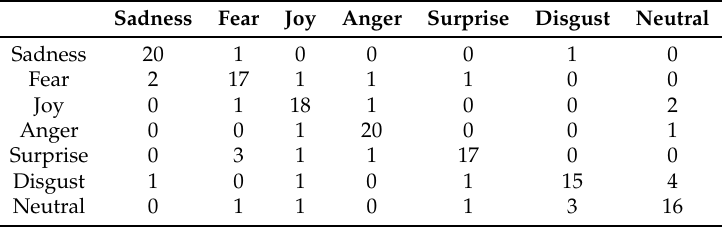
Table A13. P13 actor confusion matrix from the RekEmozio dataset in the second phase.